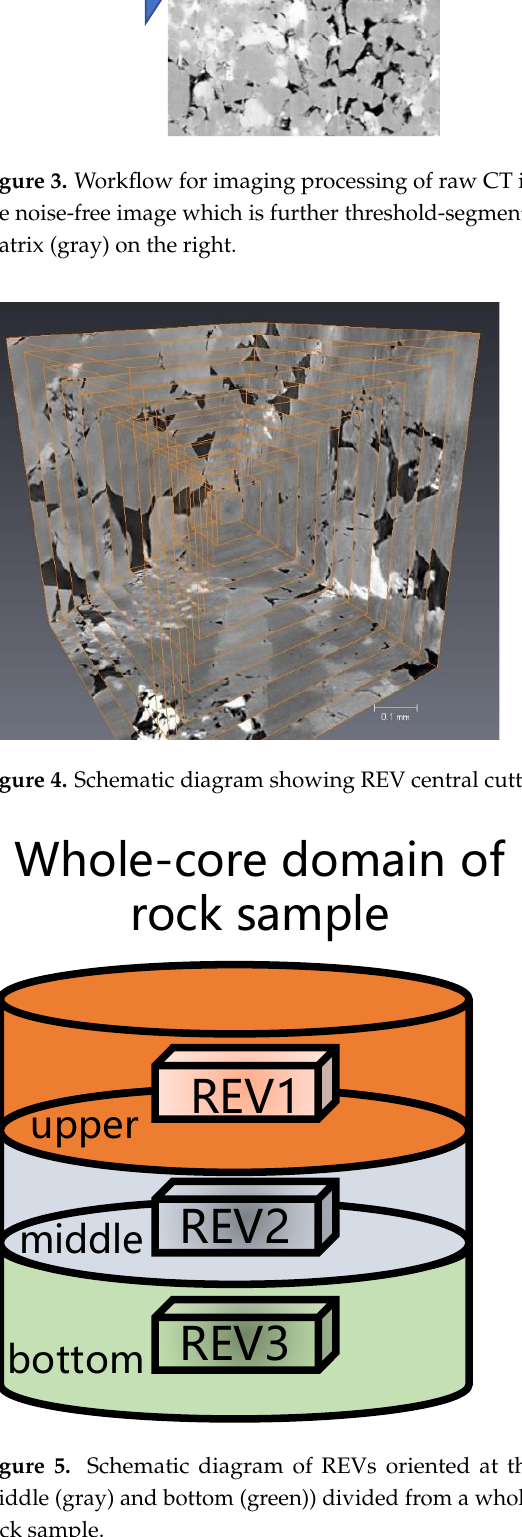
Figure 6. Results of REV analysis in terms of porosity spatial correlation (right), performed on three parts of the whole core domain defined in Figure 5, based on the REV central cutting method explained in Figure 5 with top view presented on the left.